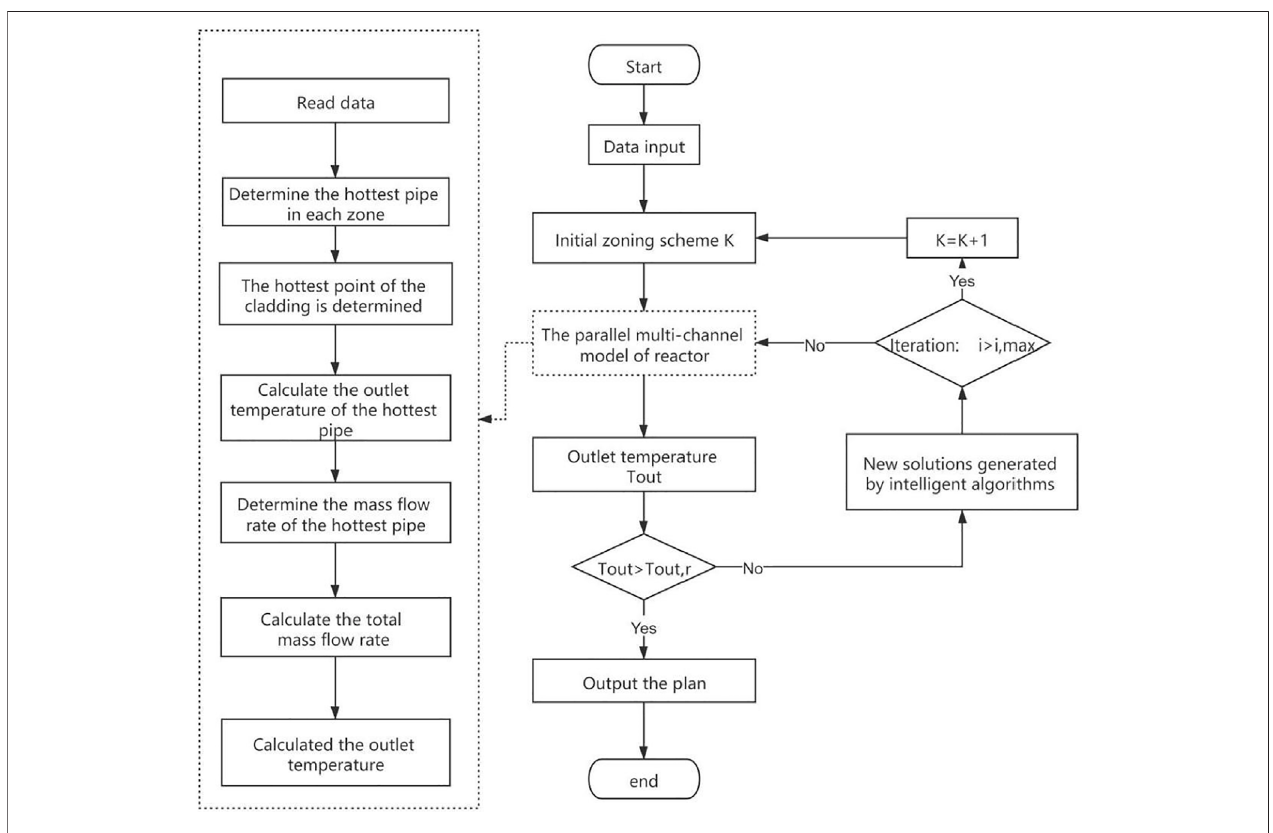
FIGURE 2 | Flow chart of fl ow partitioning algorithm design.